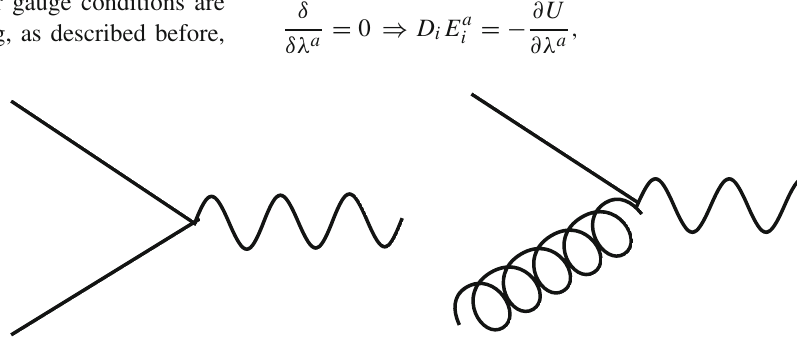
Fig. 2 Two vertices for the non-Abelian